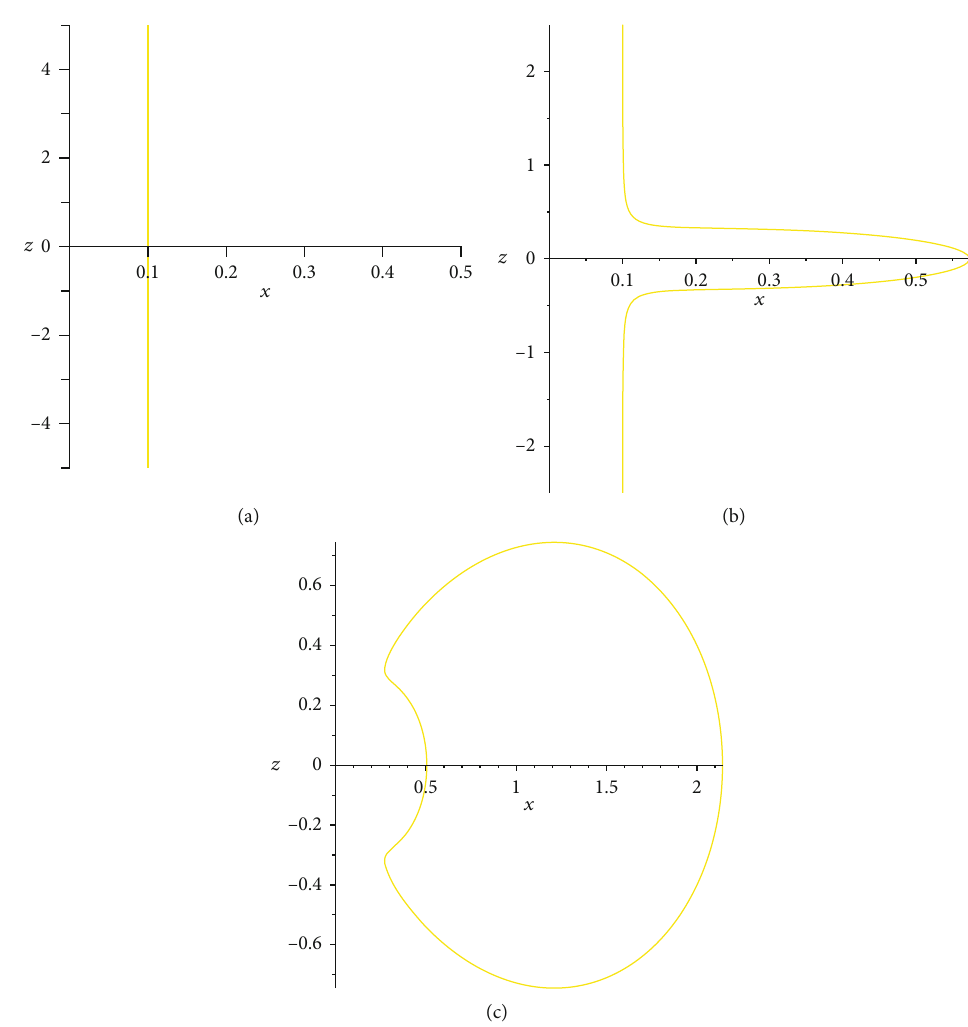
Figure 2: Revolution pro fi les around the vertical axis of light surfaces, v = 1 , corresponding, respectively, to Equations (55), (58), and (61). On these surfaces, both electromagnetic invariants vanish and the electromagnetic fi eld is rotating with the speed of light in agreement with Equation (16). Hence, two di ff erent sets of corotating observers are required on each side to describe the motion of the electromagnetic fi eld. (a) The light cylinder. (b) A cylinder with an equatorial bulge. (c) A light torus is displayed. The electromagnetic fi eld is of the pure magnetic type inside the light surfaces (a) and (b) and of the pure electric type outside of them; this situation is inverted in (c). Figures were plotted using a = 1 , k = 1 , and Ω 0 = 10